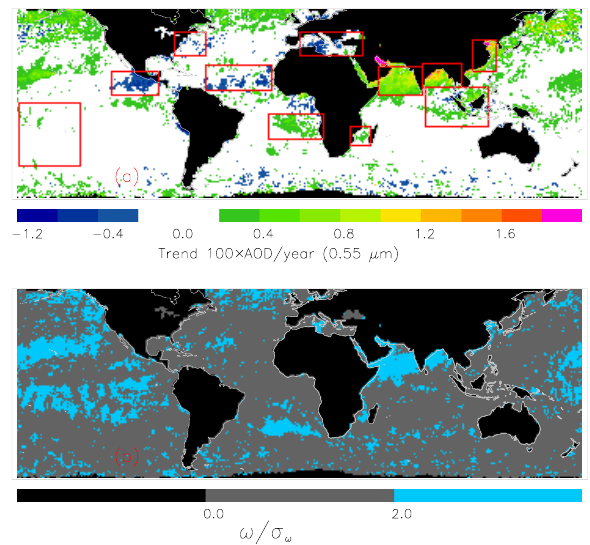
Fig. 7. (a) Spatial distribution of the ten-year AOD trends for ev- ery 1 × 1 ◦ (Lat/Lon). The ten-year trends of AOD × 100 are plotted with the use of the deseasonalized DA quality MODIS aerosol prod- uct. (b) Spatial distribution of the | ω / σ ω | values for every 1 × 1 ◦ (Lat/Lon) estimated using the same data as used in (a). Note that regions with | ω / σ ω | > 2 are consider to have real trends with a 95% confident level.